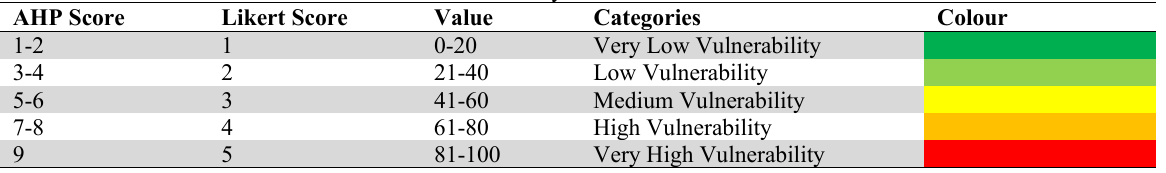
AHP and Likert scale values and the Value of Vulnerability